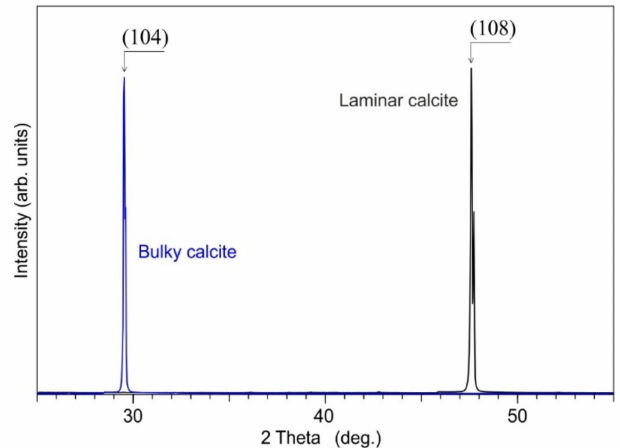
Figure 5. X-ray di ff raction patterns of the studied bladed calcites, which are dominated by the (104) reflection in the bulky crystal habit and by the (108) reflection in the more laminar crystals. Complete XRD patterns of calcite are shown in Figure